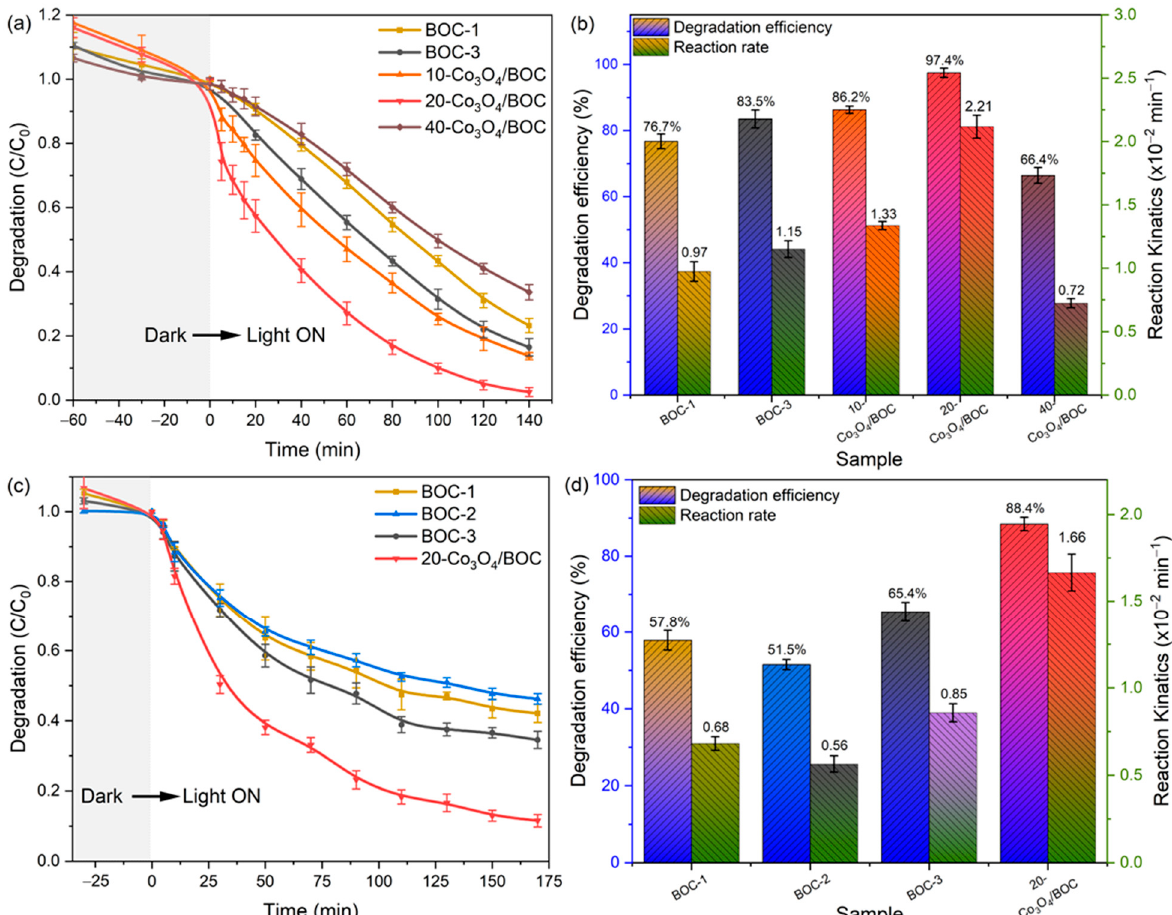
Figure 3. ( a ) Photocatalytic degradation curves of RhB, ( b ) its degradation efficiency with reaction rate constant, in the presence of BOC-1, BOC-3, 10-Co 3 O 4 /BOC, 20-Co 3 O 4 /BOC, and 40-Co 3 O 4 /BOC, ( c ) photocatalytic degradation of BPA, and ( d ) its degradation efficiency with reaction rate constant in the presence of BOC-1, BOC-2, BOC-3, and 20-Co 3 O 4 /BOC.